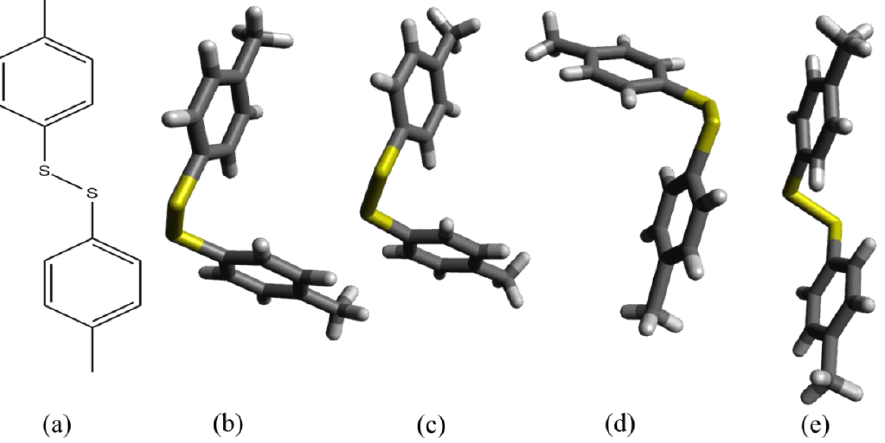
Figure 1. The structures of p-Tol 2 S 2 . ( a ) Shows molecular structure of p-Tol 2 S 2 . ( b ) and ( e ) show 3D structures (stick models) of phases α and γ, respectively. ( c ) and ( d ) show two conformations (stick models) of phase β. Table 1. The experimental [25] and computed crystal structure parameters of α , β , and γ phases of p-Tol 2 S 2 at atmospheric pressure.